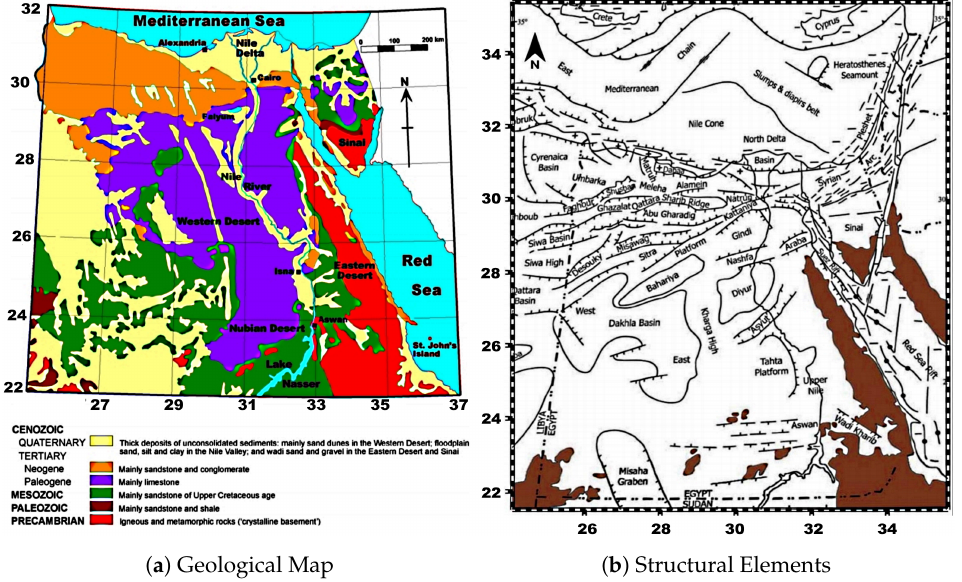
Figure 2. ( a ) A simplified geological map of Egypt [28], ( b ) Map of Egypt and the southeastern Mediterranean Sea with the essential structural elements and sedimentary basins